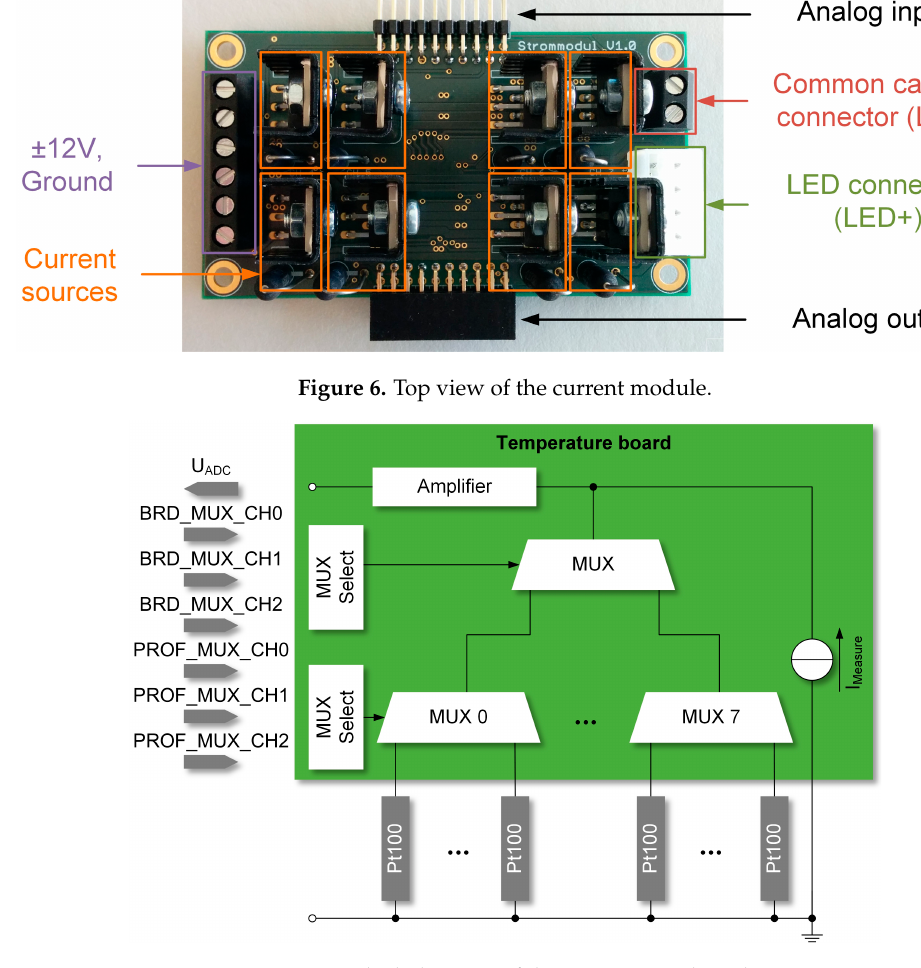
Figure 7. Block diagram of the temperature board.